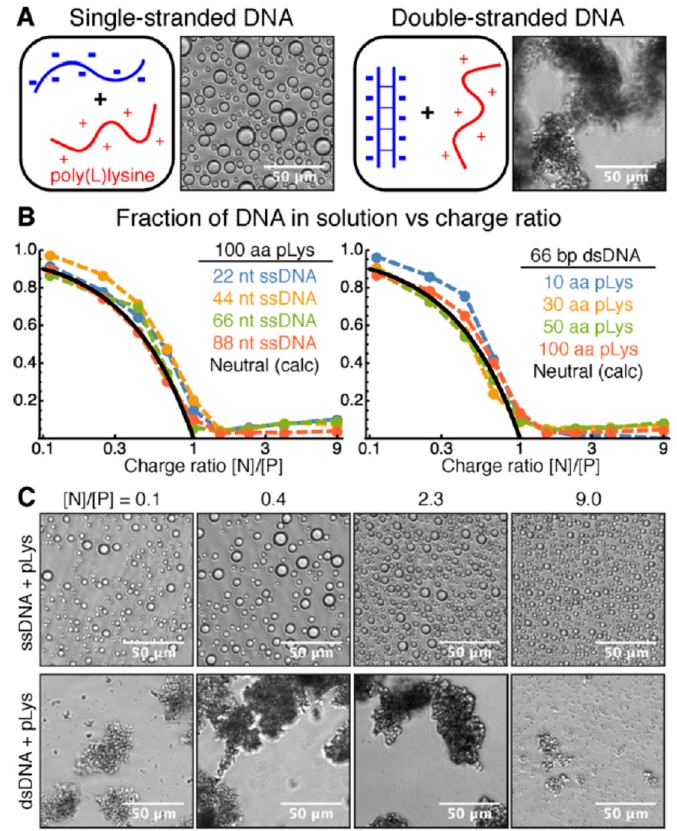
Figure 3. Typical micrographs of complexes formed by 22 nt oligonucleotides and 50 amino acid pLys peptides mixed at equal charge (amine and phosphate) concentration. Reprinted with permission from JACS , 2018, 140, 1632. Copyright 2018 American Chemical Society .